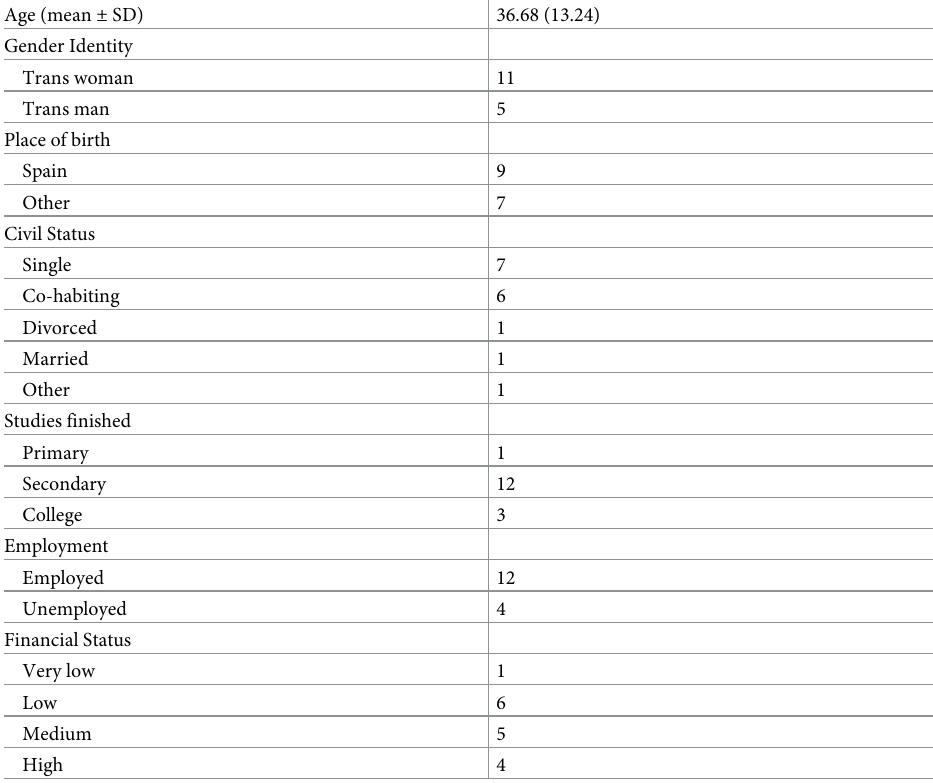
Table 2. Participants’ socio-demographic